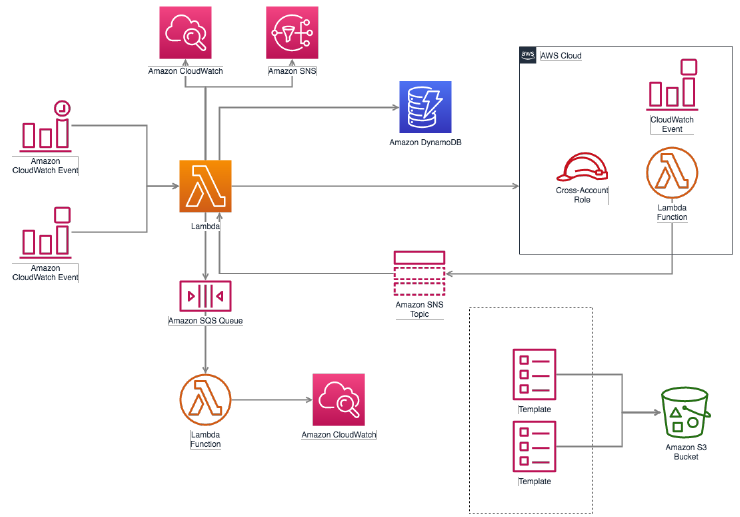
Figure 2. Basic architecture of AWS Platform for creating an